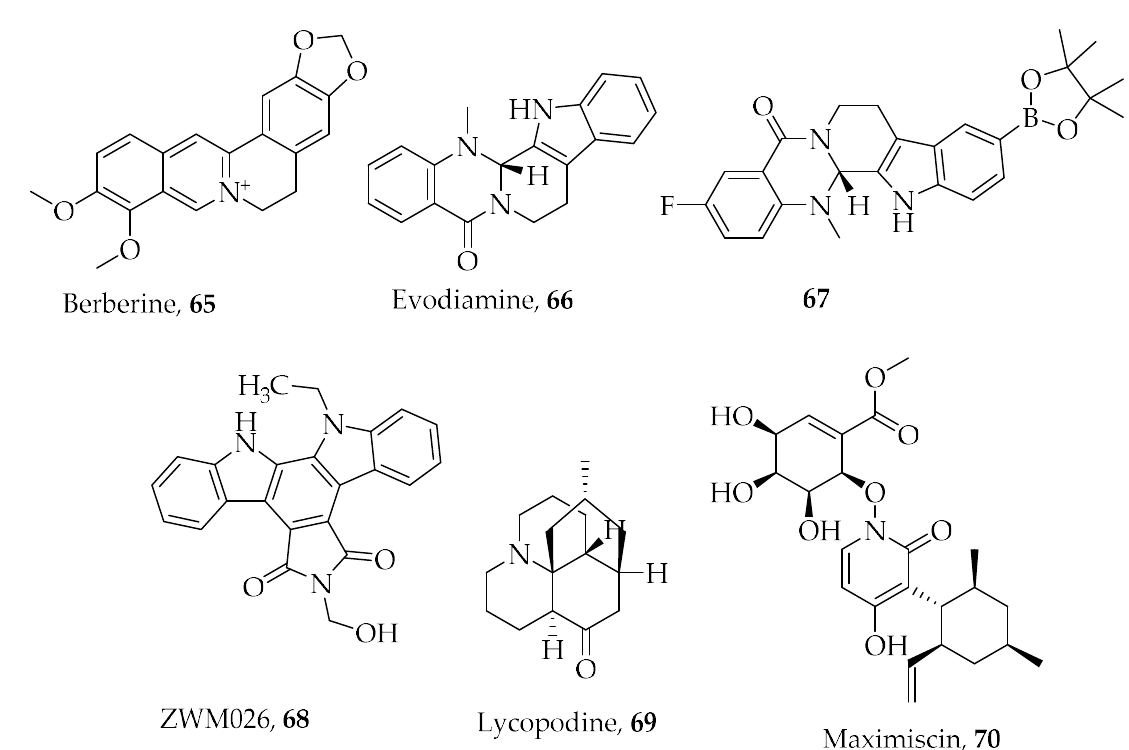
Figure 7. N -heterocyclic natural product compounds with multi-target effects on cancer cells.